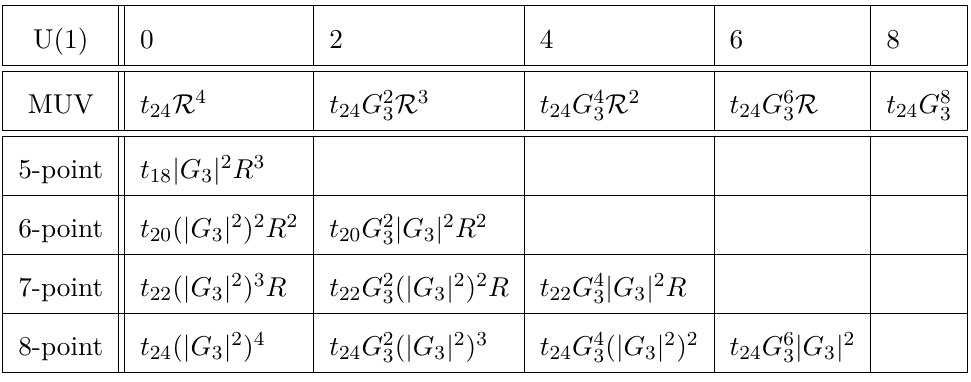
Table 3: 3-form contact terms that are captured by t 24 and a suitable definition of R